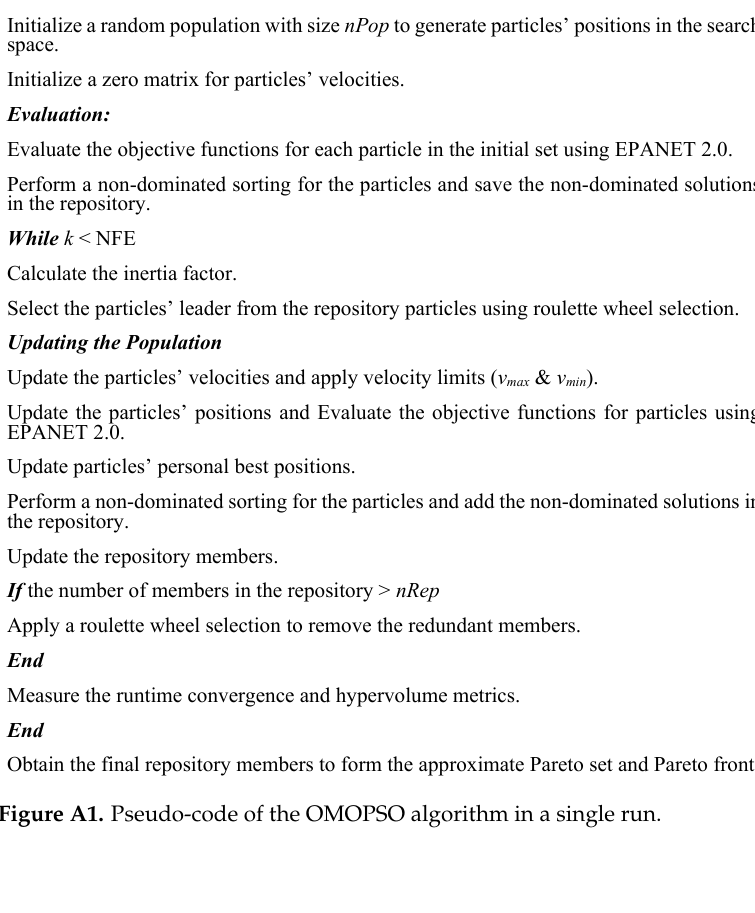
Figure A1. Pseudo-code of the OMOPSO algorithm in a single